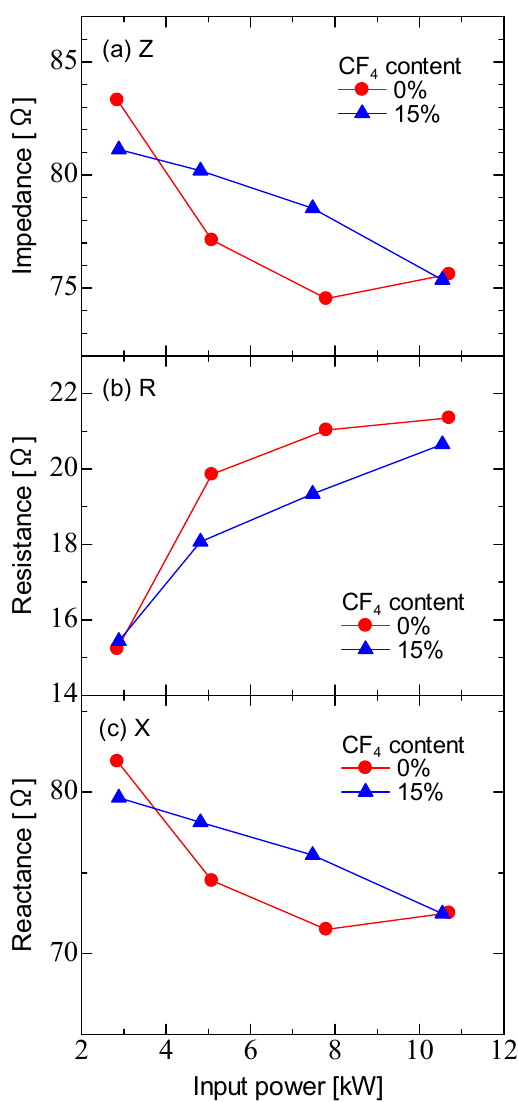
Figure 5. Electrical characteristics of the ICP as a function of input power for Ar discharge and Ar/CF 4 discharge. ( a ) impedance, ( b ) resistance and ( c ) reactance.